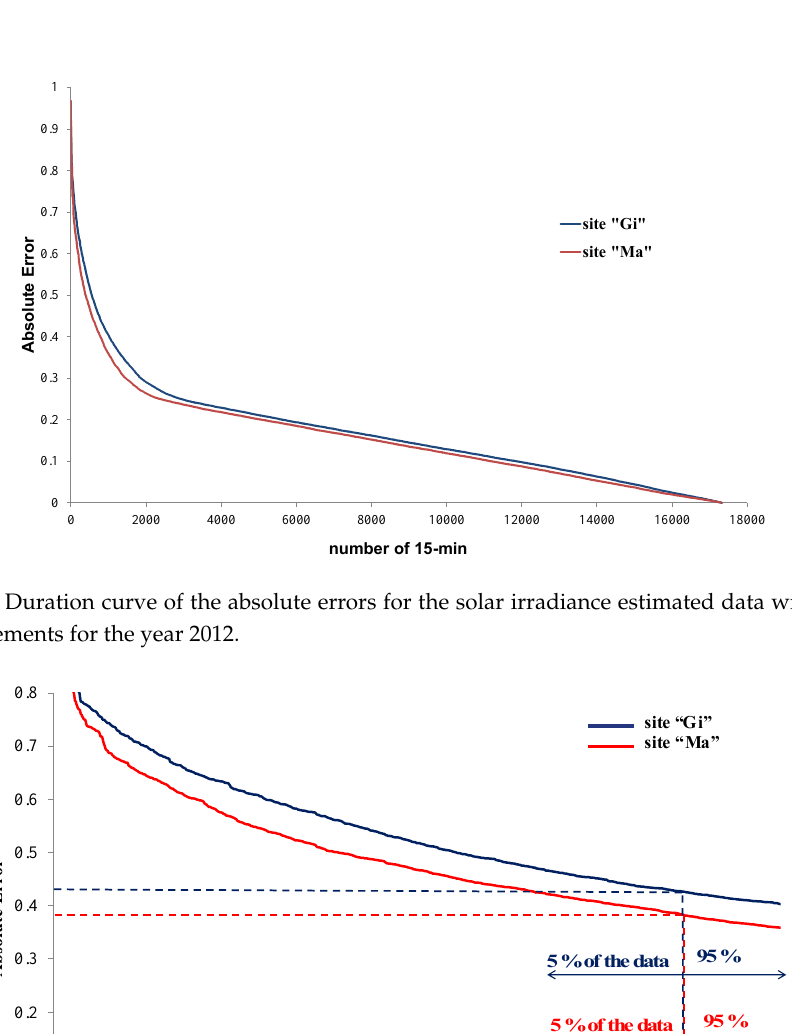
Figure 9. Zoom of the duration curves of negative bias for the solar irradiance estimated data with respect to measurements for the year 2012 at the sites “Gi” and “Ma”.